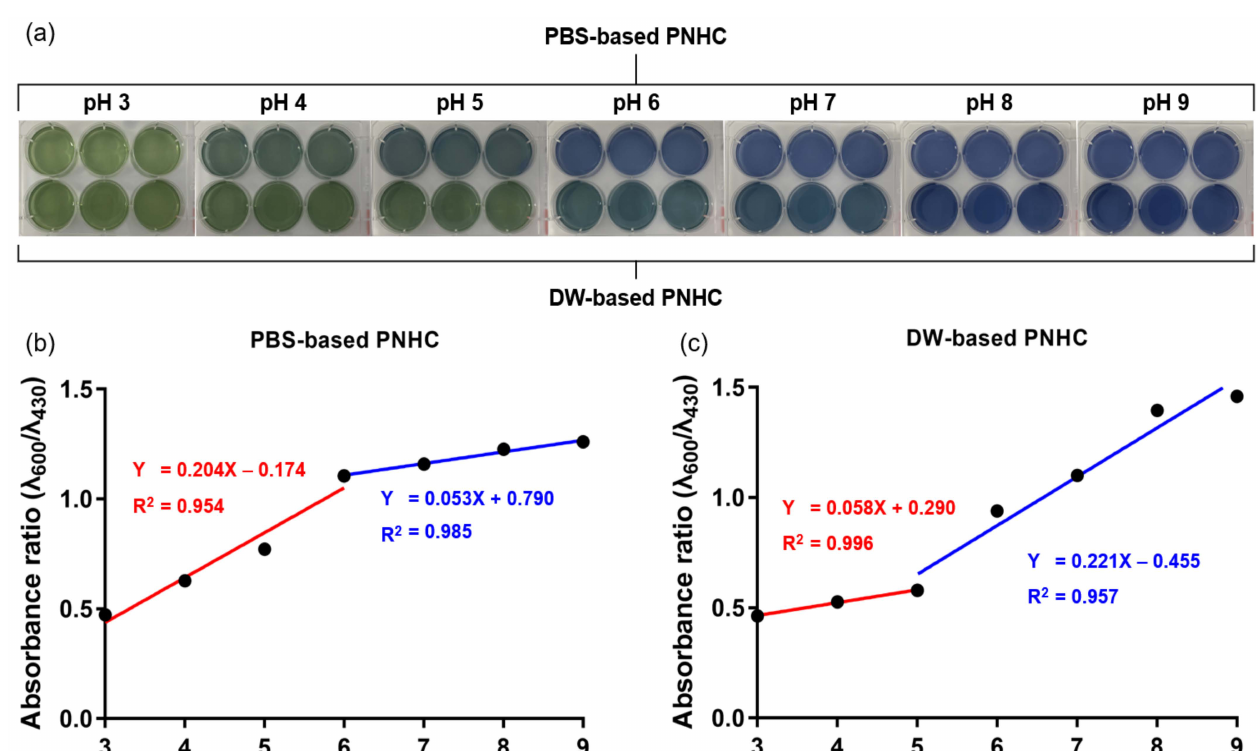
Figure 5. Effect of the solvent type and pH on the intrinsic color of PNHC. ( a ) Images for 14 different types of PNHCs that were fabricated based on PBS (pH 3–9) and DW (pH 3–9). ( b ) Absorbance ratio ( λ 600 / λ 430 ) of the PBS-based PNHC and ( c ) DW-based PNHC due to the pH of the solvent used in the PNHC fabrication. For all the data point, the error bars are shorter than the symbol